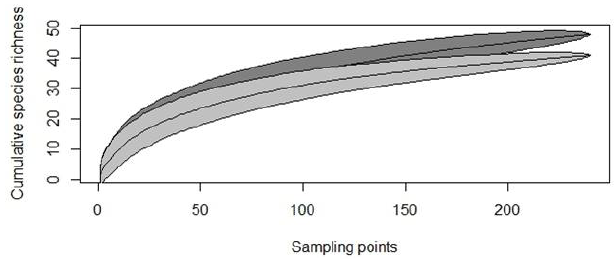
Fig 2 . Curve of accumulated species richness per point over 12 months sampling, where the shaded area corresponds to the standard error. In dark gray the accumulated richness in burned area four months before the first sampling and in light gray accumulated richness in the unburned area.